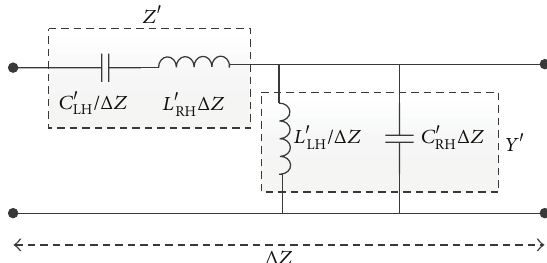
Figure 1: Infinitesimal circuit model of lossless DNG transmission line.